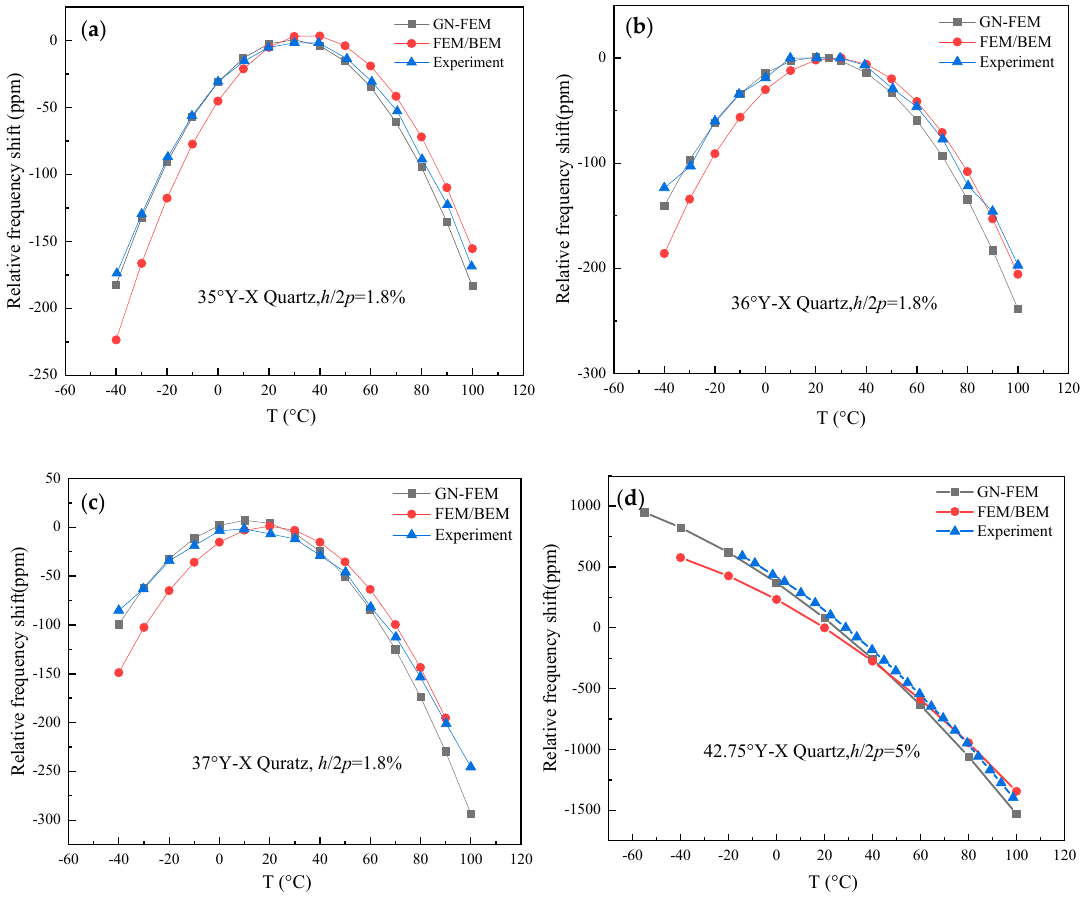
Figure 7. Comparison of the theoretical result and the experimental relative frequency shift of the quartz resonator. ( a ) 35.0 ◦ Y-X quartz; ( b ) 36.0 ◦ Y-X quartz; ( c ) 37.0 ◦ Y-X quartz; ( d ) 42.75 ◦ Y-X